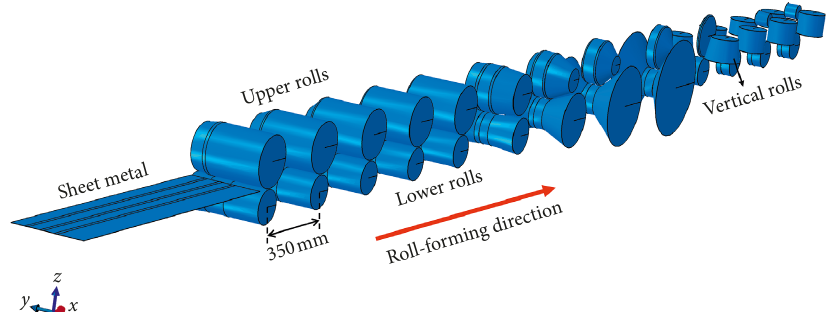
Figure 10: Assembly drawing of finite element model for roll forming of b-shaped tube.